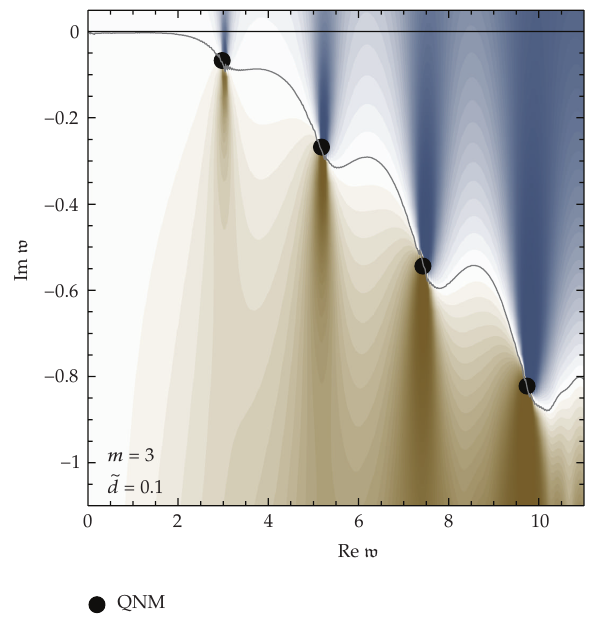
Figure 13: A contour plot of the spectral function in the complex w -plane. Blue shading indicates R > 0, brown shading indicates R < 0. The gray contour traces R (cid:5) 0. The values along the line Im w (cid:5) 0 represent the physical spectrum we plotted for several parameters